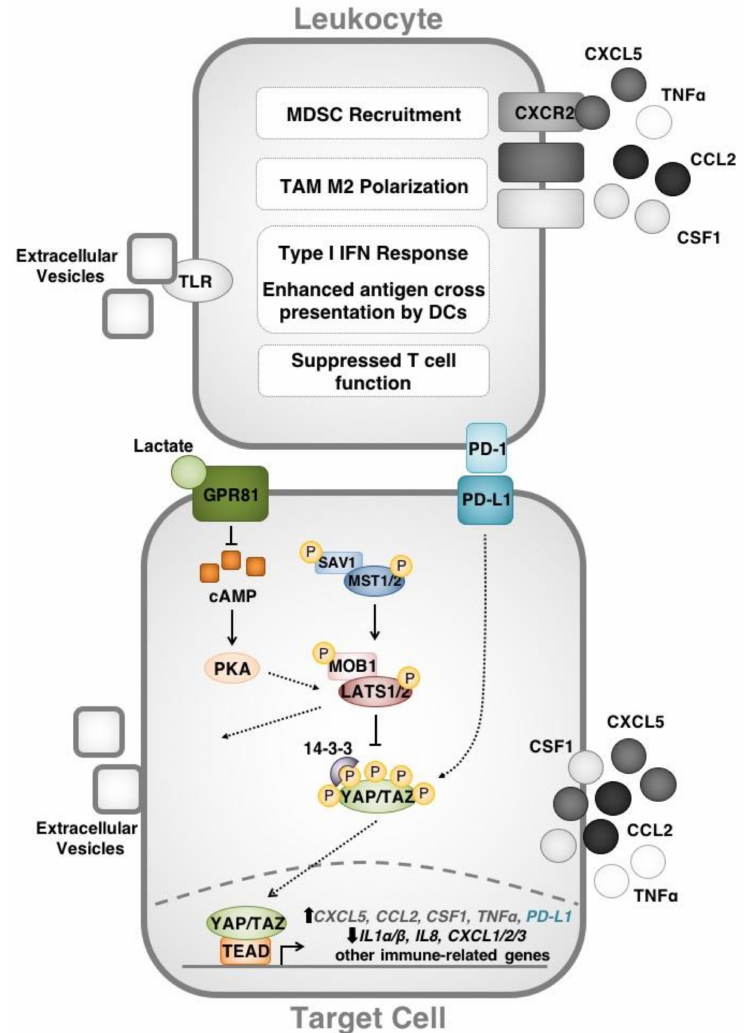
Figure 2. Overview of the Hippo signaling pathway in modifying the anti-neoplastic immune response. The Hippo pathway effectors YAP/TAZ regulate gene targets that direct immune cell function. Cytokines upregulated by YAP including CXCL5 and TNF α recruit myeloid-derived suppressor cells (MSDCs) to the tumour microenvironment while others (CSF1 and CCL2) direct tumour-associated macrophage (TAM) M2 polarization. YAP/TAZ act downstream of Hippo signaling (as well as GPCR signaling) to directly enhance PD-L1 expression and disrupt T cell function through PD-L1/PD-1 binding. Finally, LATS, YAP and TAZ affect the nucleic acid content of extracellular vesicles that modify Toll-like receptor (TLR) signaling, the type 1 interferon (IFN) response and antigen presentation by dendritic cells (DCs). Interactions that have been described in human cells are shown in colour while those that have been demonstrated in murine cell lines are shown in